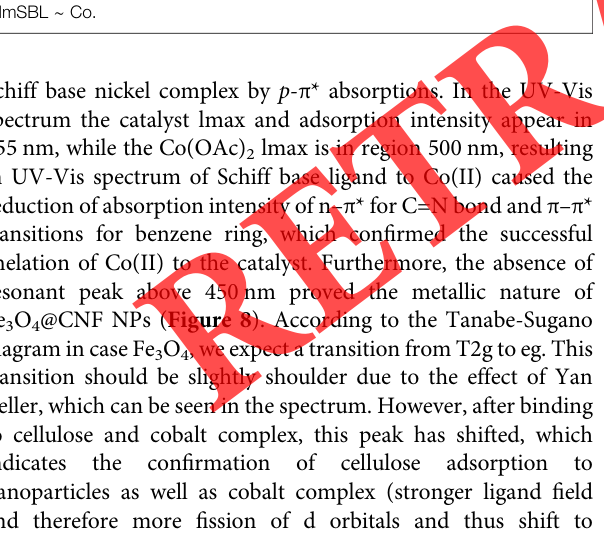
FIGURE 7 | XRD spectra of (A) Co(OAc) 2 , (B) Fe 3 O 4 , (C) Fe 3 O 4 @CNF ∼ ImSBL ∼ Co.